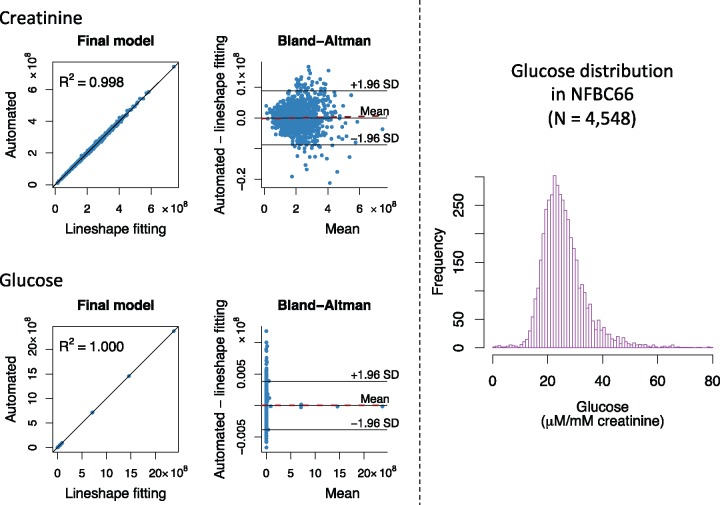
The automated quantification of urinary creatinine and glucose from the NMR spectra. On the left: building and assessment of the final automated regression models for the absolute signal areas for creatinine and glucose in the NMR spectra (n = 999). Training and independent testing results are shown in Supplementary Figure 1, available as Supplementary data at IJE online. In the Bland-Altman plots, the solid line in the middle represents the mean bias (between the automated regression and the line shape fitting analyses results for the absolute signal area) and the two others the mean ± 1.96 SD. The dashed red line represents the regression line for the bias. The equations for the regression lines are y =0.9977x + 4.772×105 for creatinine and y=1.000x+31.88 for glucose. Bias as a function of creatinine: y=1.135×10-3x-2.390×105 with R2 = 0.0006 and bias as a function of glucose: y=2.180×10-6x-15.94 with R2 = 0.000001. Both automated regression models show excellent quantitative performance and robustness with negligible bias. On the right: the distribution of absolute urinary concentration (in µm/mM creatinine) in 4548 urine samples in NFBC66. The absolute signal areas for the urinary creatinine and glucose used to calculate the distribution are based on fully automated NMR spectral analyses using the final models illustrated on the left. The urinary glucose distribution is positively skewed (88 glucose concentration values >80  µm/mM creatinine are not drawn for clarity). This is expected, due to individuals with prediabetes and diabetes in NFBC66.